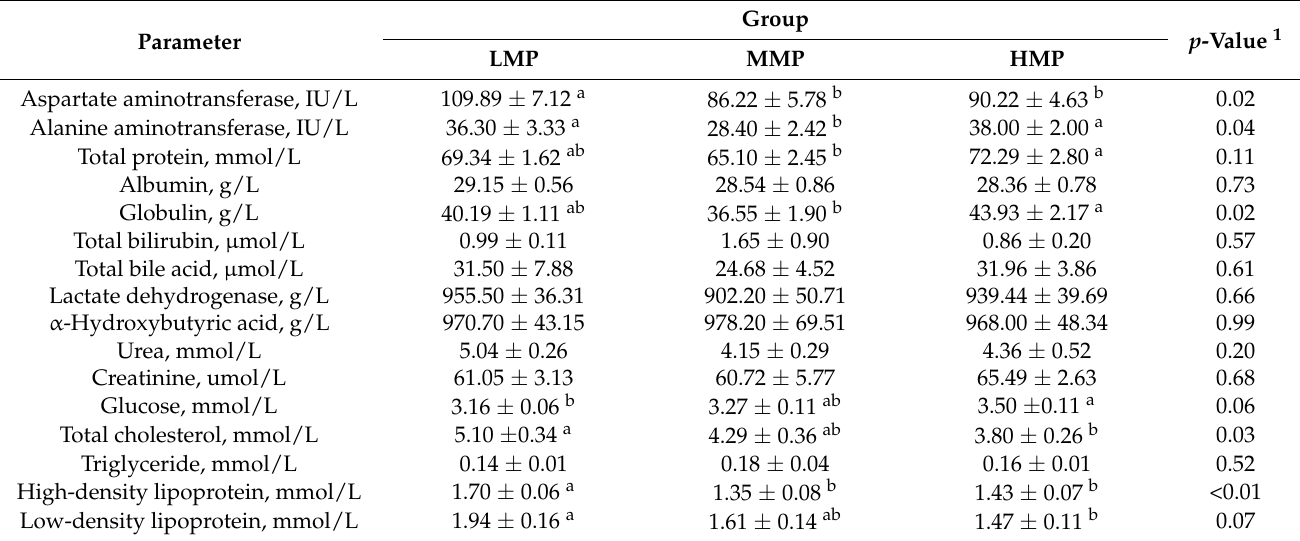
Table 1. Plasma biochemical parameters of cows with different milk protein